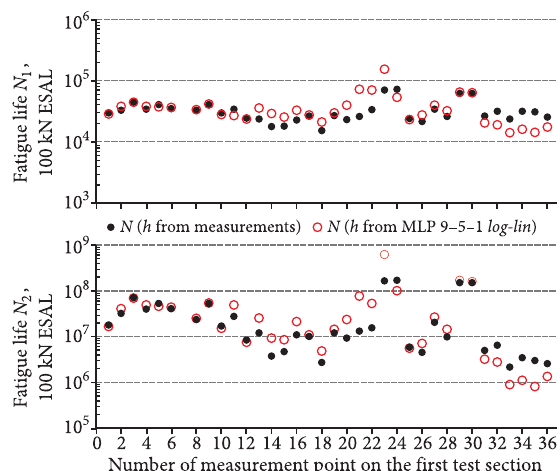
Fig. 8. Analytical fatigue life data for a pavement structure test